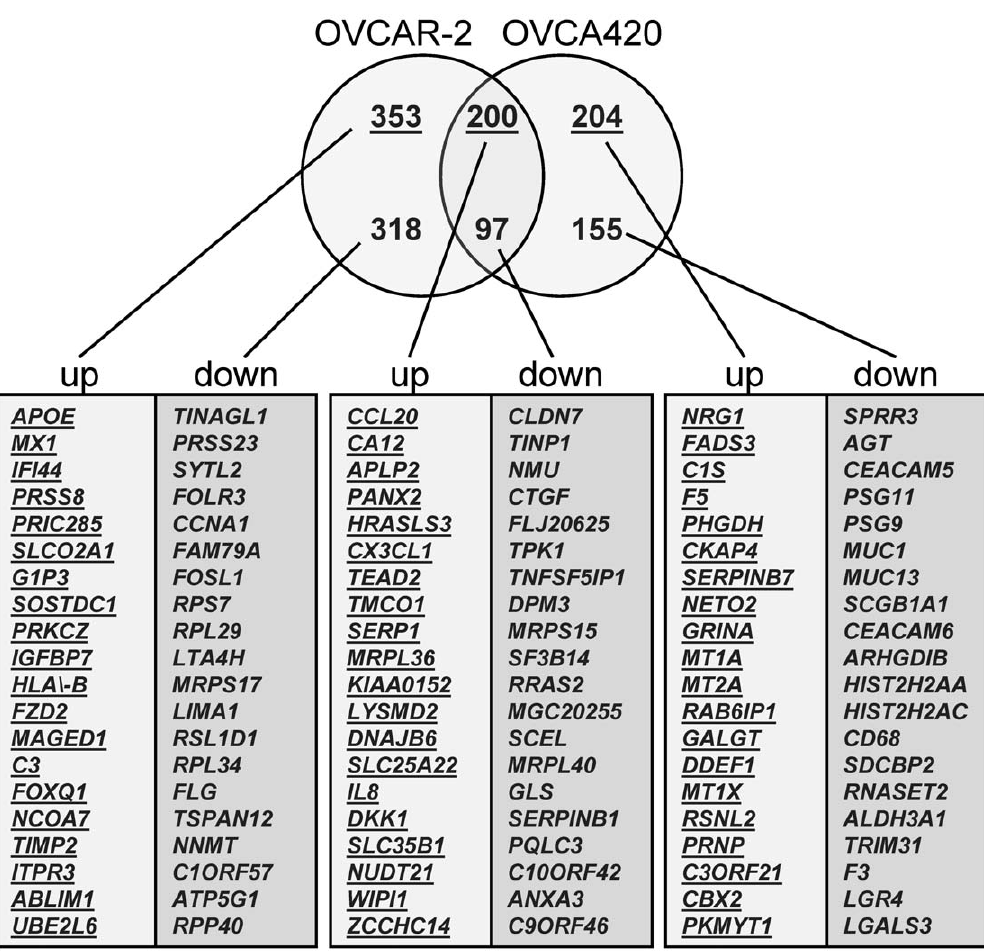
Figure 4. Venn diagram showing the genes up-regulated and down-regulated in OVCAR-2 and OVCA420 following CLDN7 knockdown (absolute fold change . 1.4). In the Venn diagram, numbers in red represent genes up-regulated and numbers in green represent genes downregulated. The top 20 genes in each category are indicated in the table below the Venn diagram.